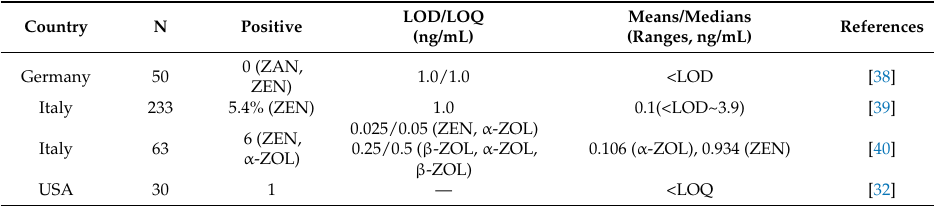
Table 3. Occurrence of ZEN biomarkers in human